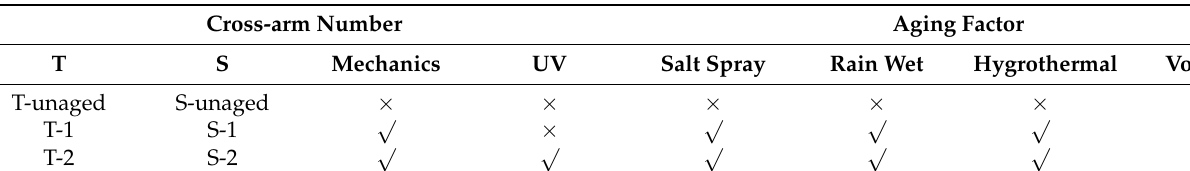
Table 4. Composite cross-arm aging sample.